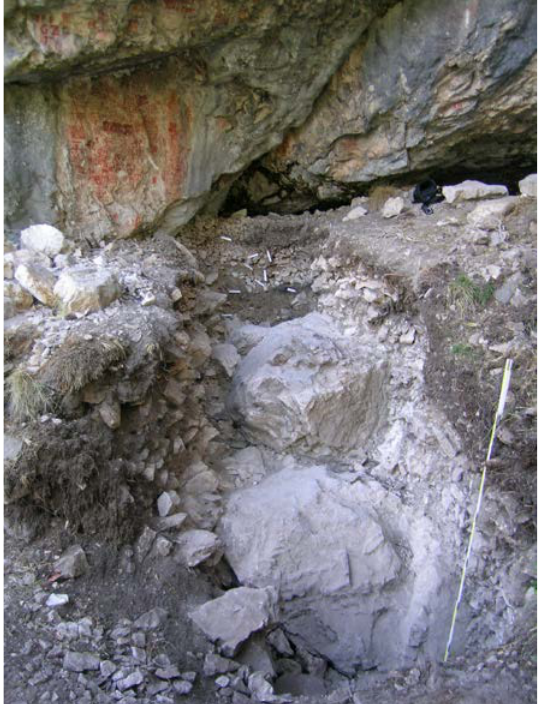
Figure 9 – Ziano di Fiemme – the Trato shelter: the frieze and the excavation. Photo by Marta Bazzanella. Courtesy of Museo degli Usi e Costumi della Gente